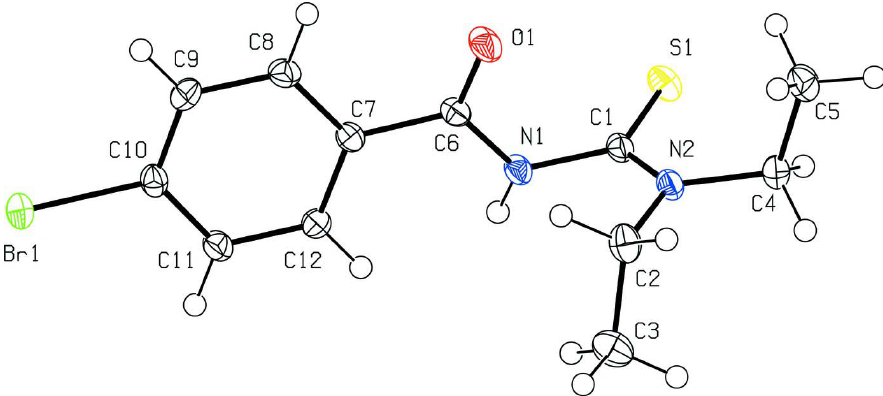
The molecular structure of (I). Displacement ellipsoids are drawn at the 50% probability